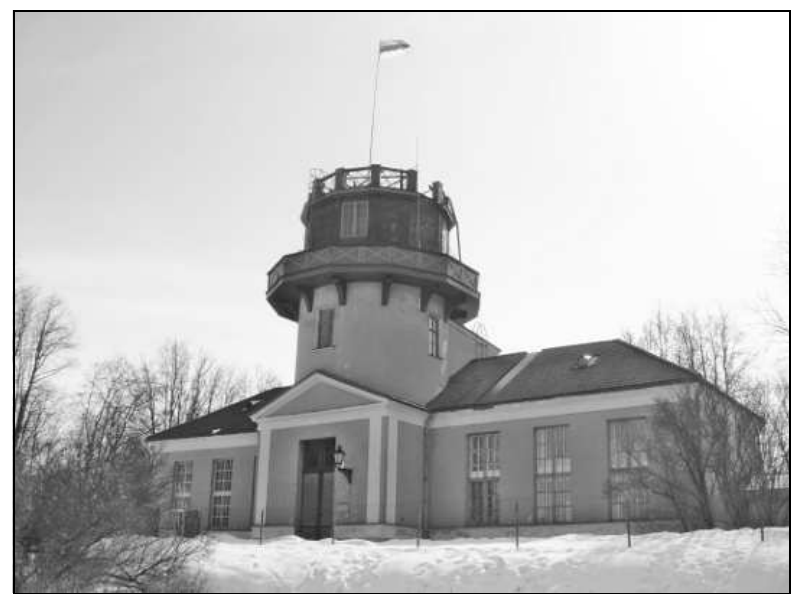
Fig. 8. Tartu T(cid:127)ahetorn. Image: Michael